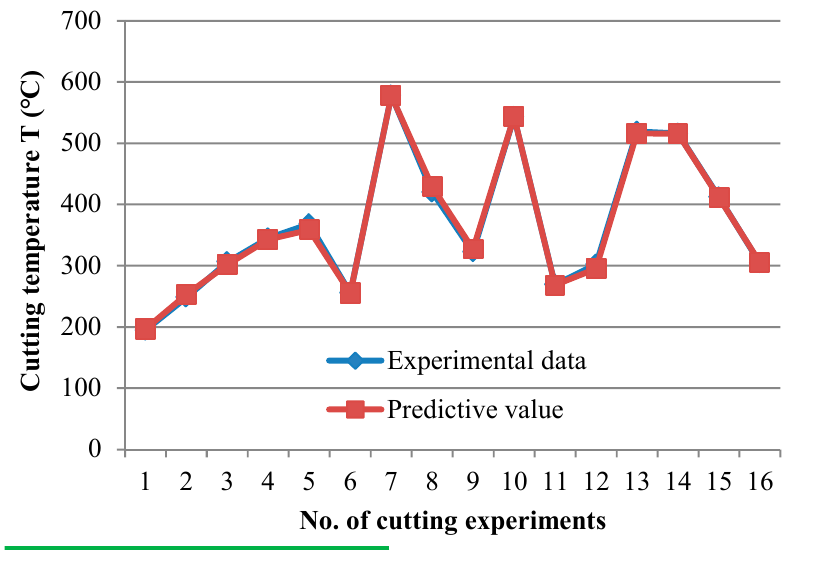
Figure 7. Plot of means for the maximum cutting temperature T .